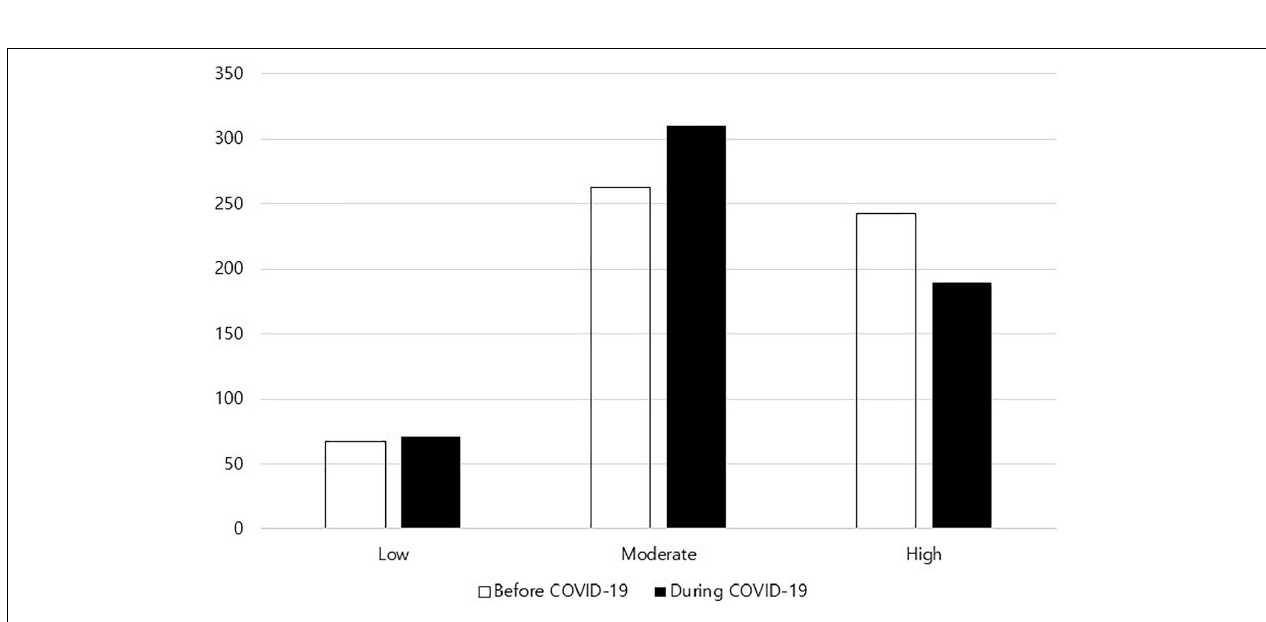
FIGURE 2 | Physical activity classification of females before and after COVID-19.